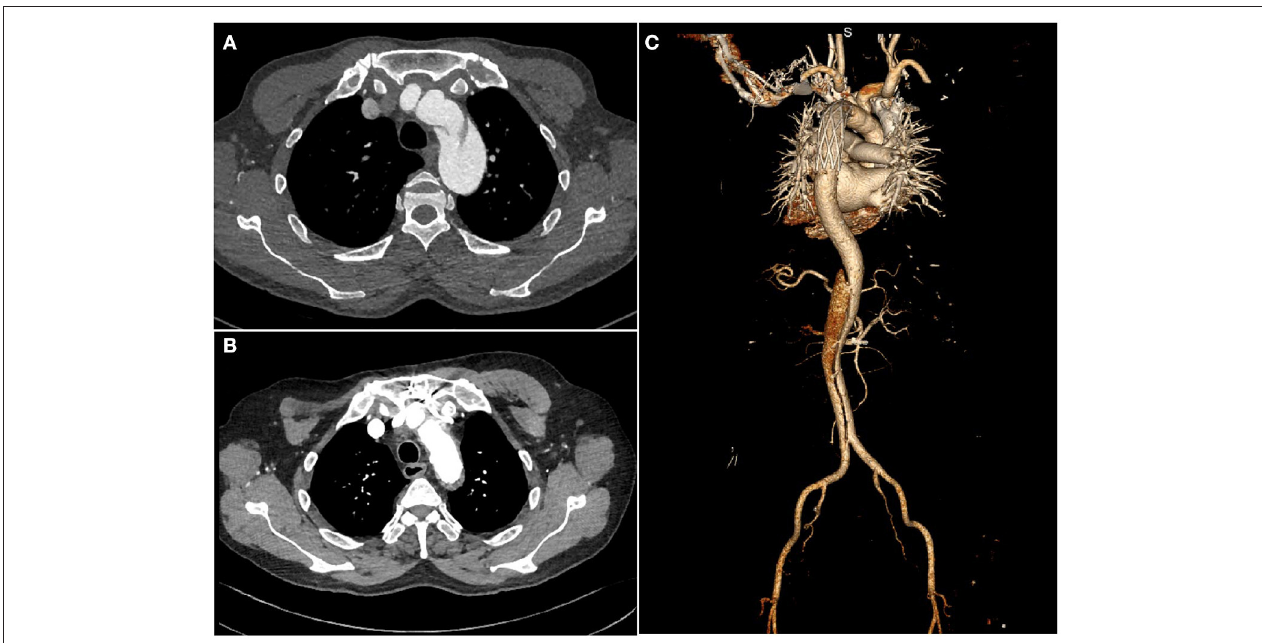
FIGURE 2 | Computed tomography images of a patient with chronic type B dissection with aortic arch involvement (A) preoperatively (B,C) ,